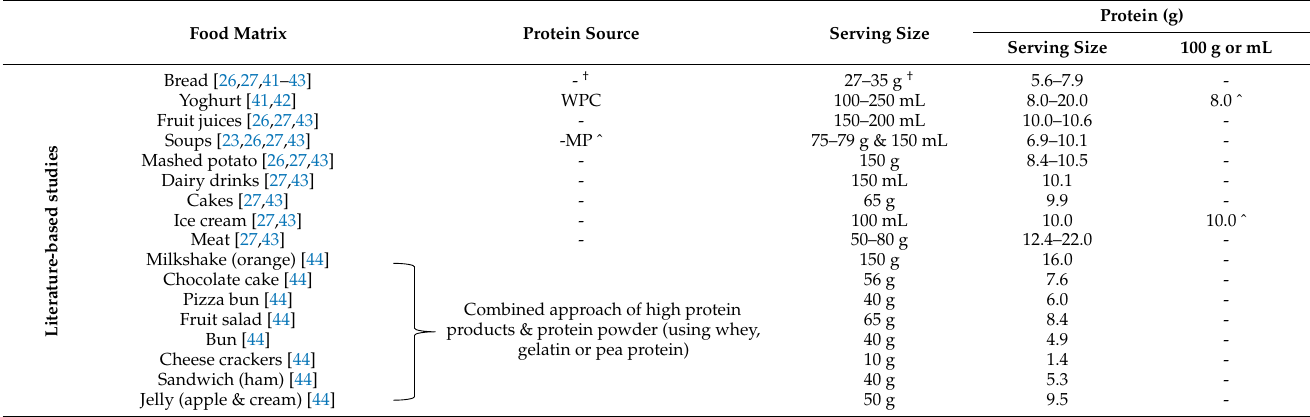
Table 2. Examples of food matrices commonly fortified with protein within the literature, clinical settings and/or retail market. Food